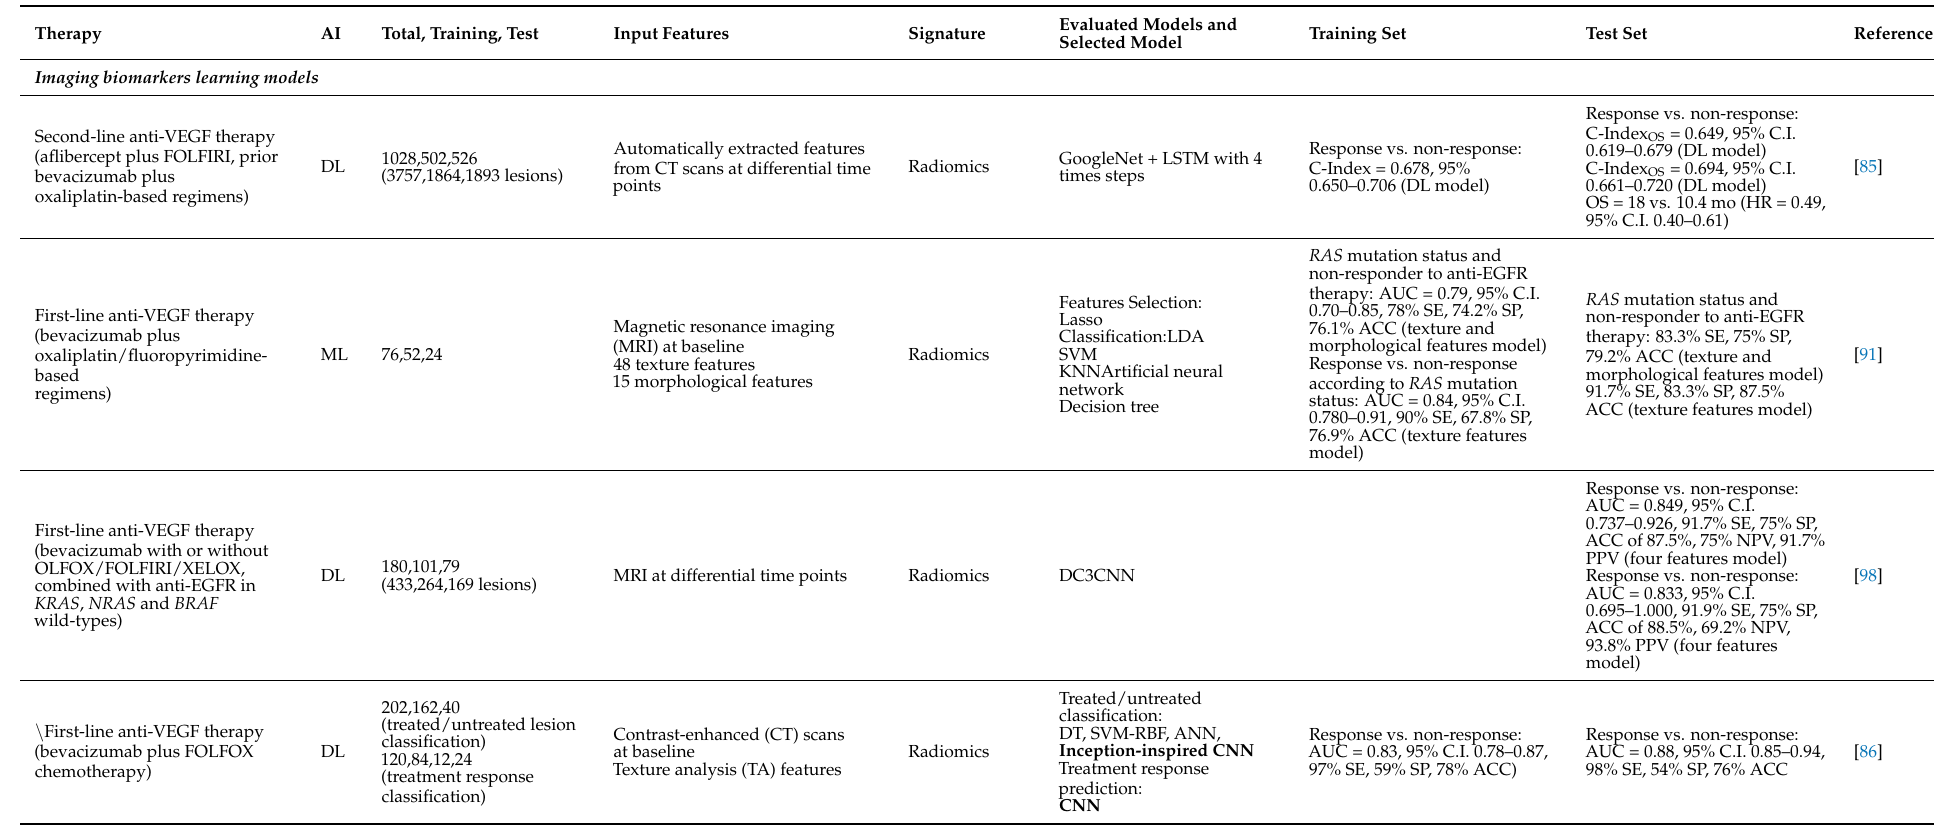
Table 3. Artificial Intelligence analysis of the response to targeted therapy for patients with colorectal metastasis. Data are grouped for imaging or biomarkers based learning